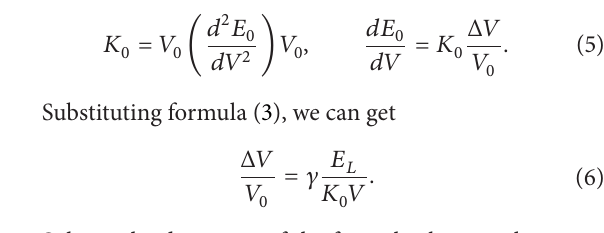
Figure 2: Epitaxial wafer model.